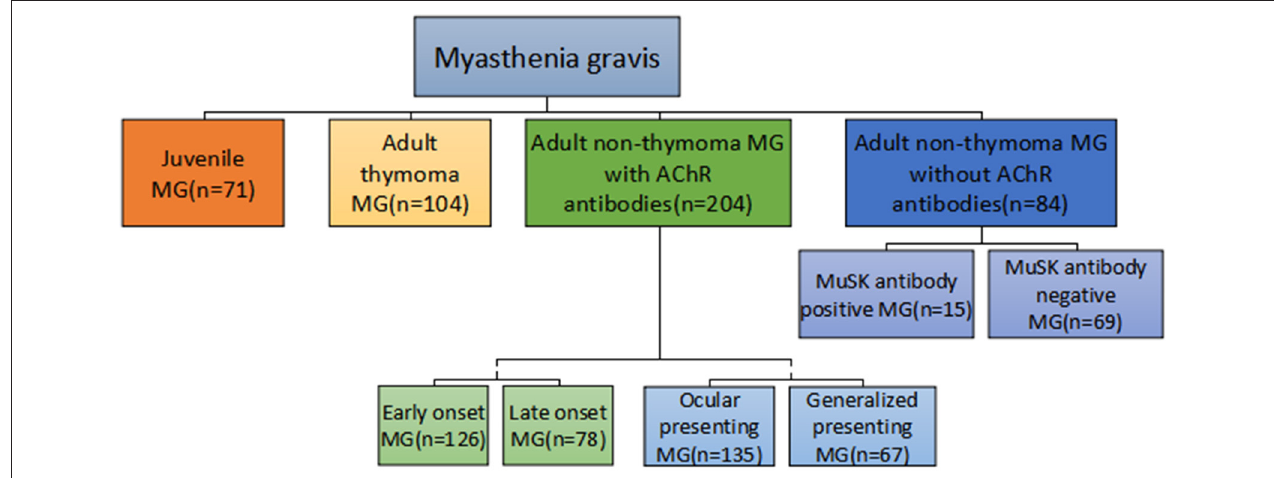
FIGURE 1 | MG comprehensive subgroup